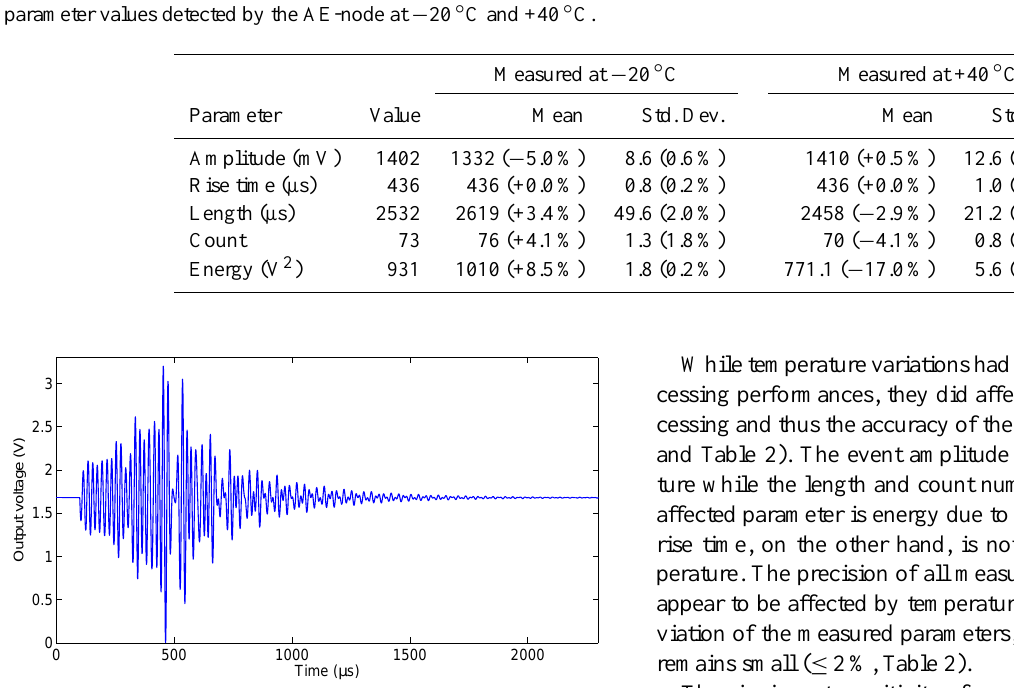
Fig. 3. Test signal generated by the waveform generator to evaluate the AE-node performance. The y-axis does not compare directly with the amplitude measured by the AE-node. During the experi- ment a post-trigger time of 800µs was